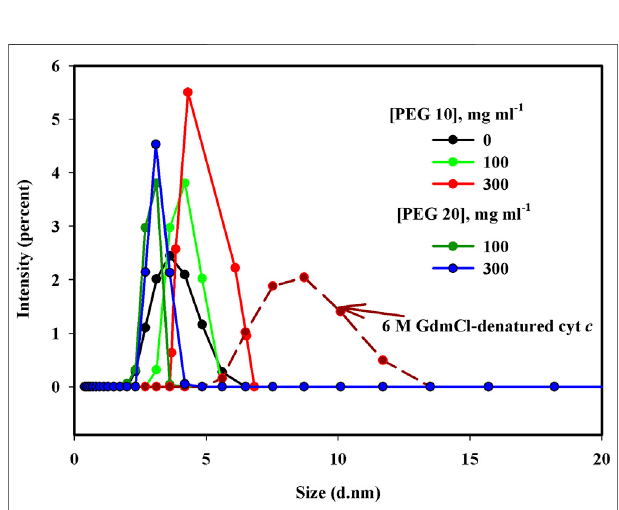
FIGURE4| Particlesizemeasurements(d.nm)ofcyt c inthepresenceof 0, 100, and 300 mg ml − 1 of PEG 10, PEG 20, and 6 M GdmCl.